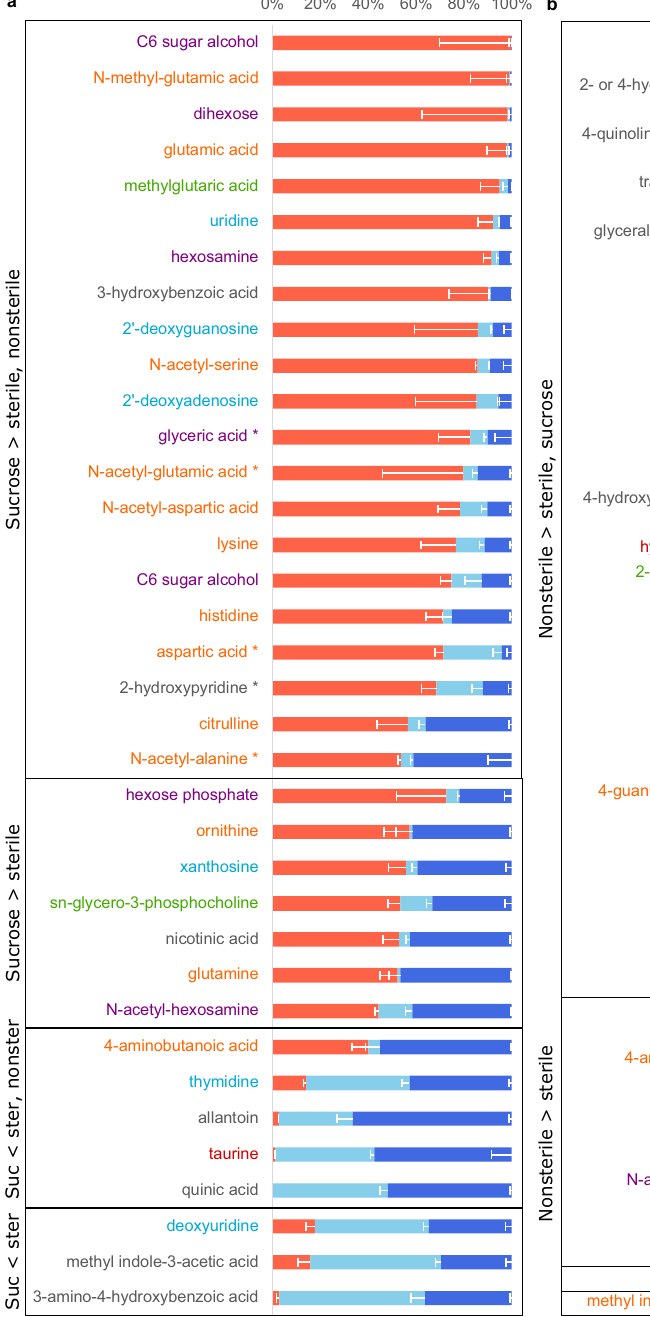
increasedordecreasedcomparedtocontrol.S:Sterile,NS:nonsterile,4-hydroxy-2: 4-hydroxy-2-quinolinecarboxylic acid, *: and/or isomers. Data are averages±SEM, n =4 – 5 jars per growth condition with 3 plants each. Metabolites are colored by class: orange: Amino acids, peptides and derivatives, purple: carbohydrates and conjugates, green: lipids and lipid-like, blue: nucleosides, nucleotides and deriva- tives, red: organic acids, black: